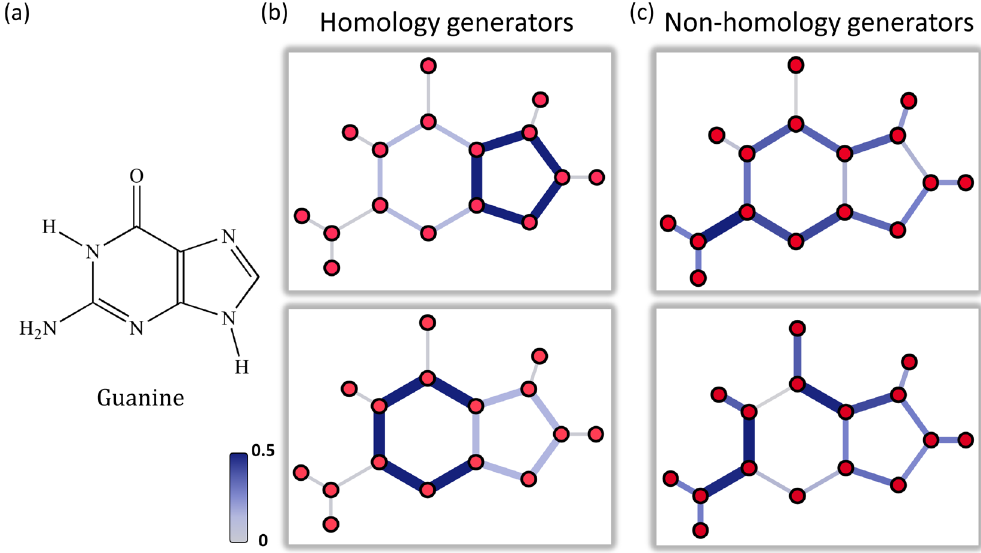
Figure 2. The illustration of HL-based structure analysis. ( a ) The graph representation for Guanine. ( b ) The zero-eigenvalue-related eigenvectors are homology generators. Geometrically, their largest absolute values indicate the associated loop structures. ( c ) Nonzero-eigenvalue-related eigenvectors are more related to domain, cluster and community